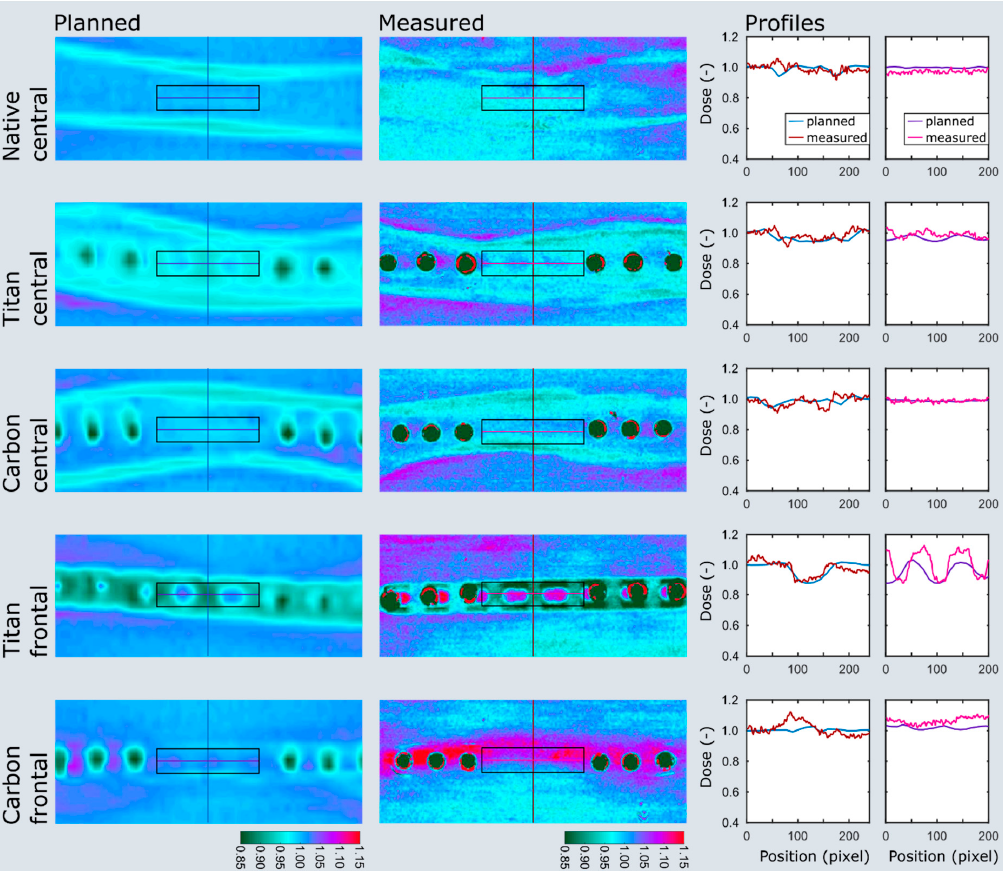
Figure 5. Dose plotting of the plate model at 5 cm immersion depth. The area of interest and profiles are depicted on the planned and measured dose distributions as black boxes and colored lines. Note the distinct dose attenuation at the implant–bone interface with titanium implants (titan frontal) when compared to CF/PEEK implants (carbon frontal). The dose range assimilates in the bone center but remains smaller in the CF/PEEK model (titan central vs. carbon central).